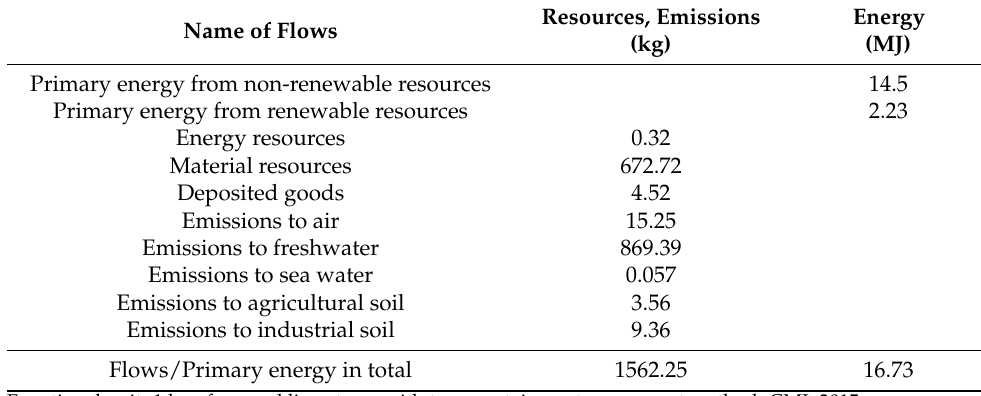
Figure 5. Hungarian electricity mix (year: 2021) (self-edited illustration). Table 6. Resources and emissions of the wet grinding process in kilograms.